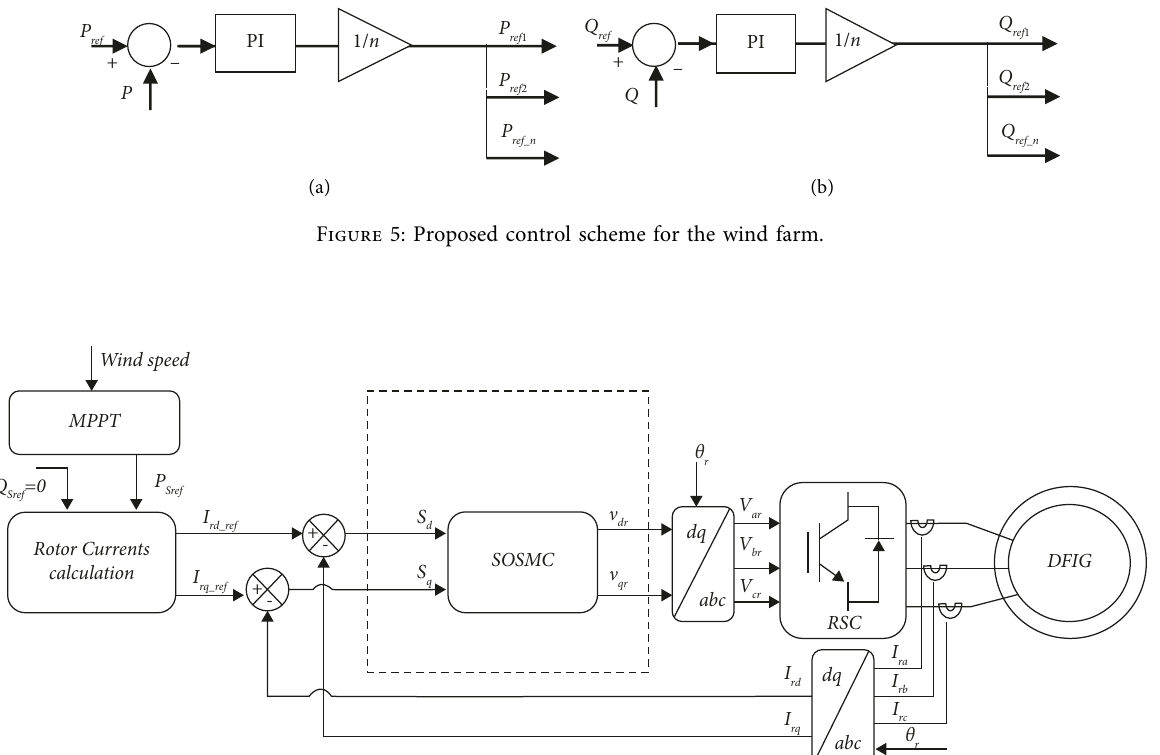
Figure 6: DFIG-based wind turbine